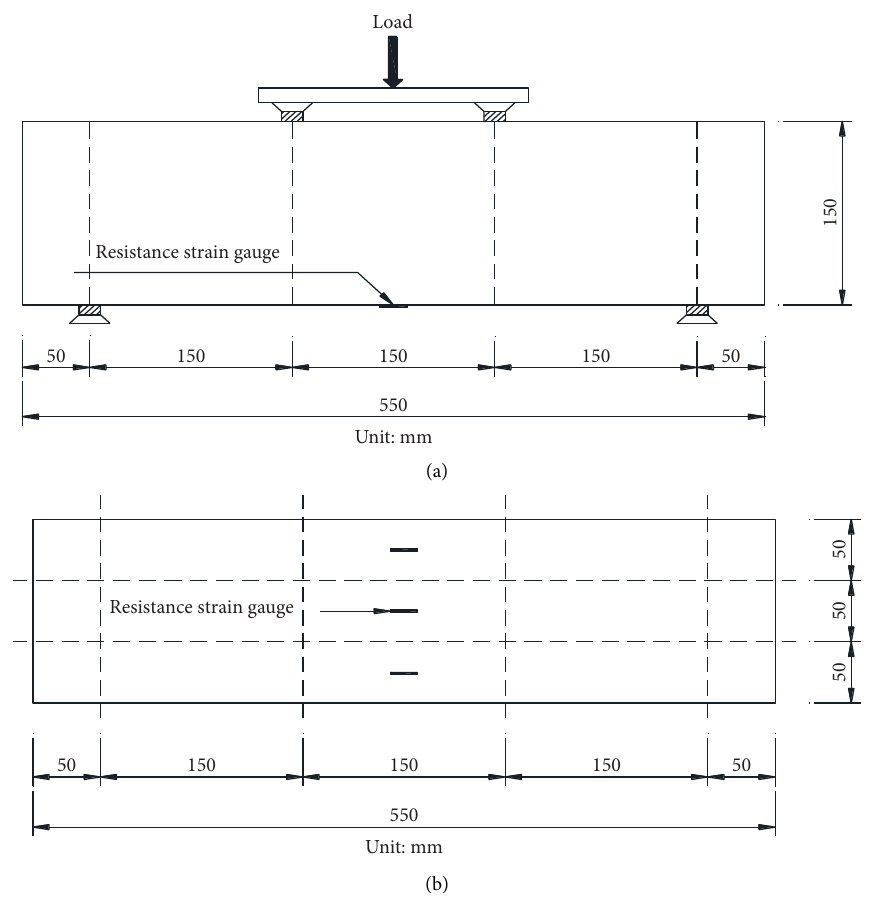
Figure 1: Flexural toughness test setup. (a) Side view. (b) Bottom of the test piece.